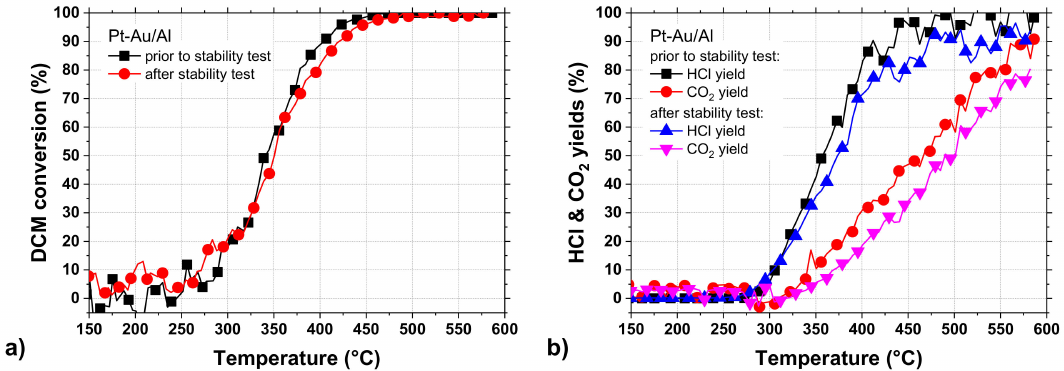
Figure 10. ( a ) DCM conversion, as well as ( b ) HCl and CO 2 yields, over the Pt-Au / Al catalyst before and after the stability test in DCM oxidation (same conditions as in Figure